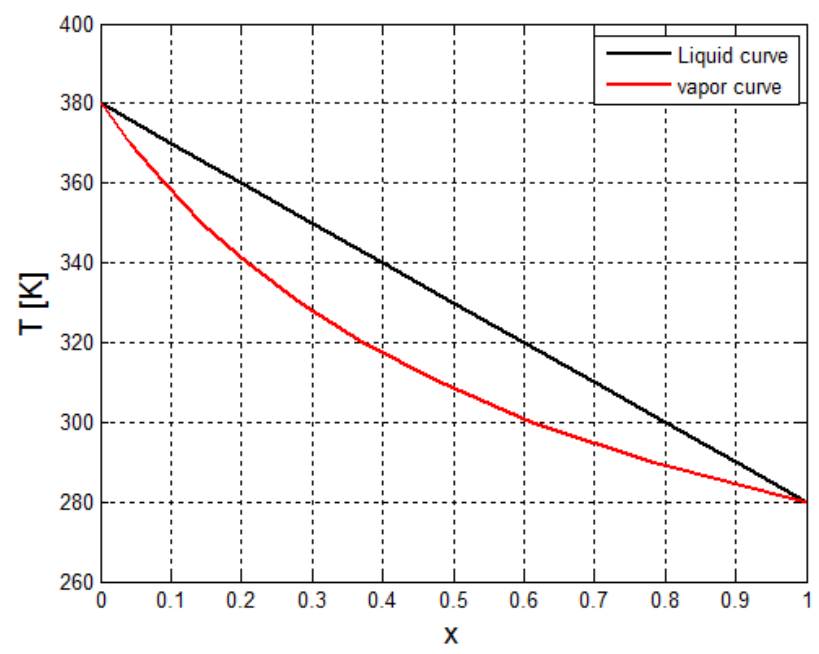
Figure 6. Equilibrium diagram for binary mixture.